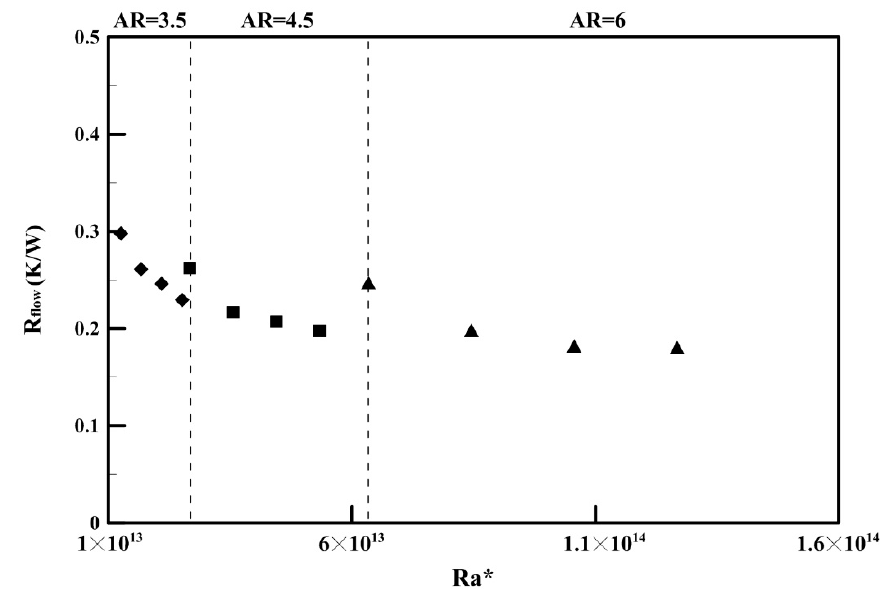
Figure 7. Relationship between the thermal resistance of the working fluid flow ( 𝑅 (cid:3033)(cid:3039)(cid:3042)(cid:3050) ) and Ra *.